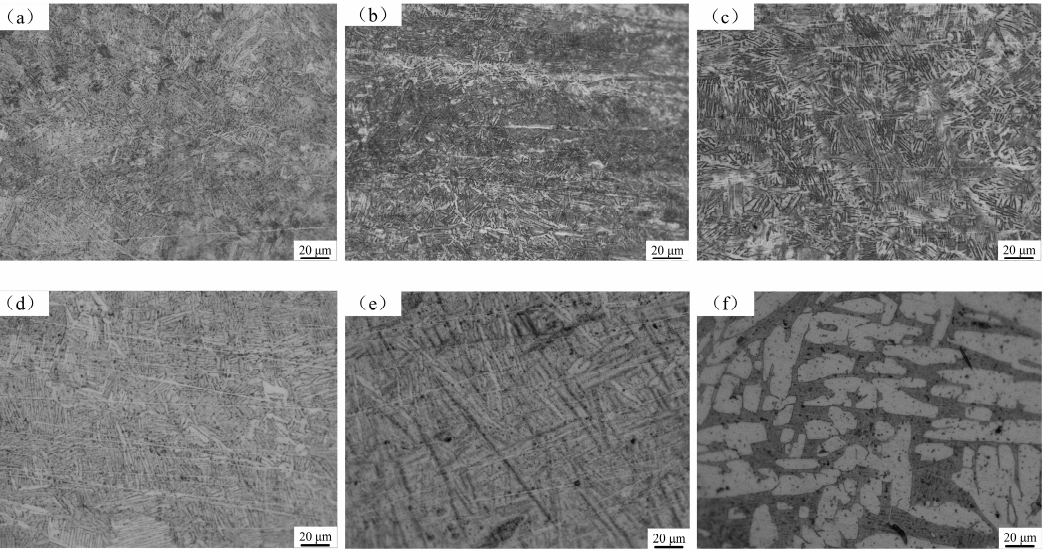
Figure 14. Microstructure after different annealing temperatures: ( a ) 700 °C; ( b ) 750 °C; ( c ) 800 °C ( d ) 850 °C; ( e ) 900 °C and ( f ) 950 °C.